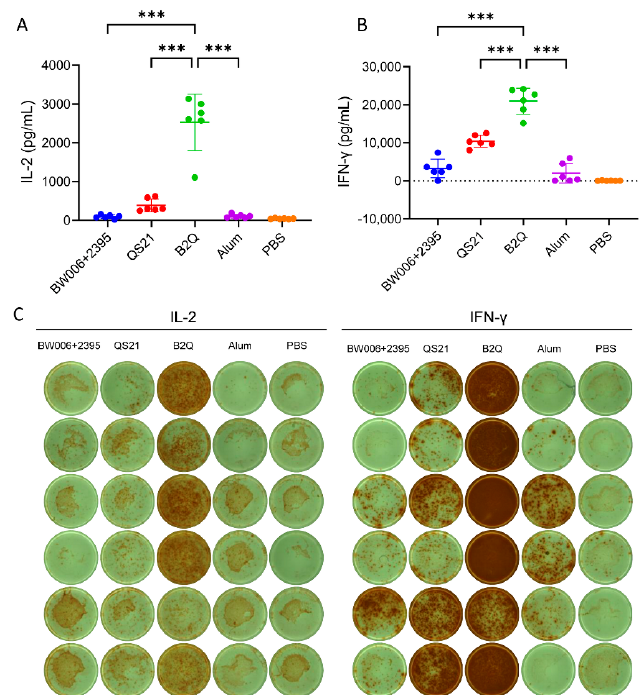
Figure 2. ELISA and ELISPOT analyses performed with splenocytes isolated from immunized mice in the adjuvant synergy study. The concentrations of IL-2 ( A ) and IFN- γ ( B ) secreted by splenocytes upon stimulation with 10 µg/mL protein gE were measured by ELISA. N= 6, each dot represents an independent mouse. Data are shown as the mean and SD and were analyzed by ANOVA, with the mean of the B2Q group used as a control. ( C ) IL-2- and IFN- γ -producing splenocytes (per 5 × 10 5 cells) induced by stimulation with 20 µg/mL protein gE were detected by ELISPOT. Images for all immunized mice are presented. N = 6. *** p ≤ 0.001.